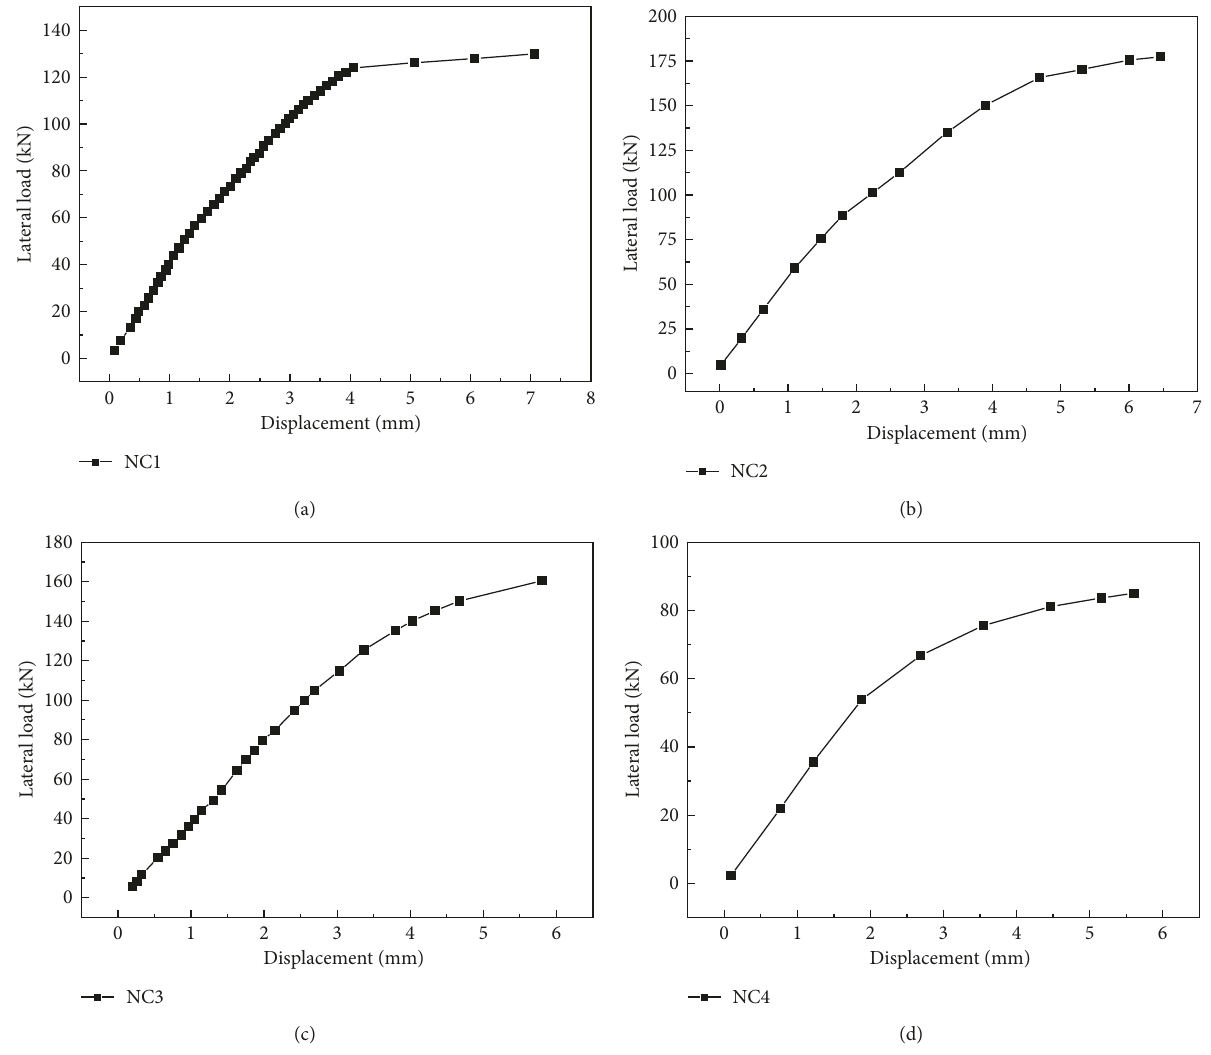
Figure 12: a–d) Lateral load ( P ) versus lateral displacement (